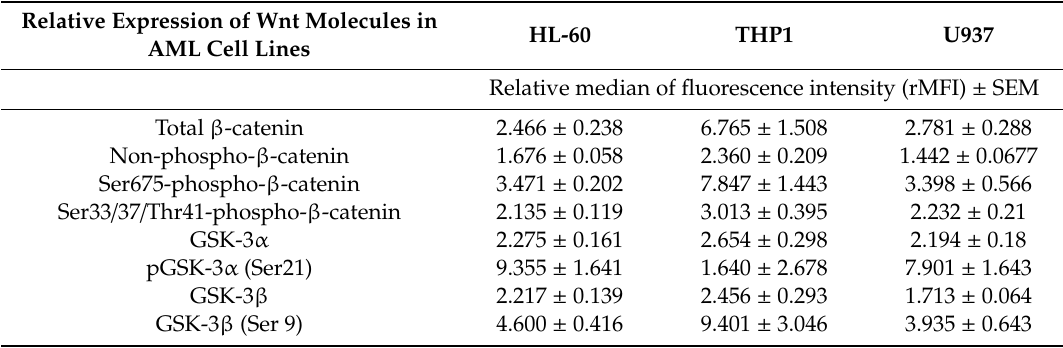
Table 1. Flow cytometric analysis of Wnt / β -catenin and GSK-3 molecules in AML cell lines. HL-60, THP1 and U937 were probed with specific primary antibodies and labelled with Alexa 488-conjugated secondary antibodies. Data are expressed as relative median of fluorescence intensity and reported as mean ± SEM of 6 independent